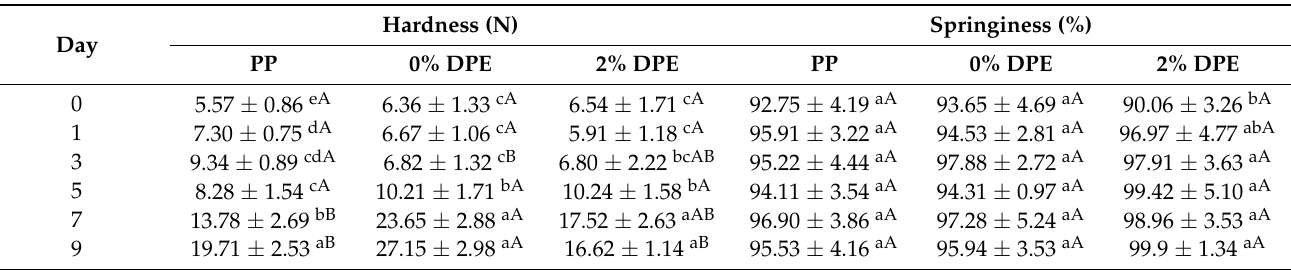
Table 4. Texture profile analysis of coconut milk candy wrapped in polypropylene and DPE-enriched biocomposite